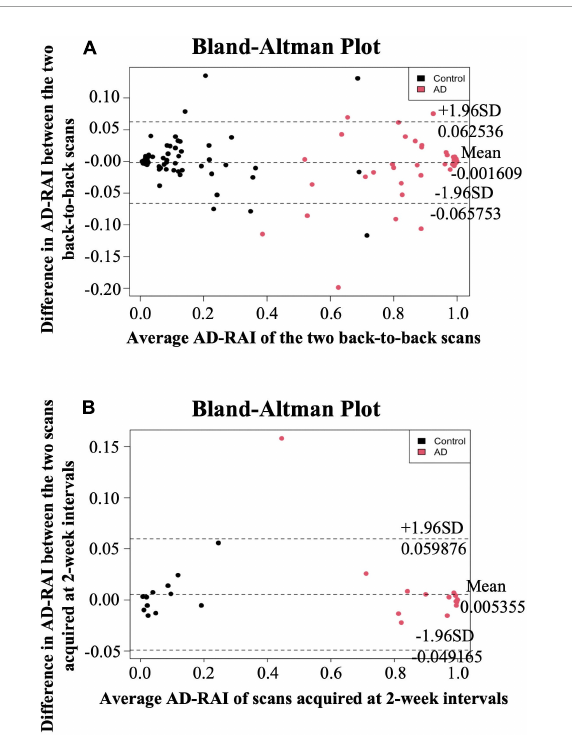
FIGURE1 Bland-Altman plots for same-day repeatability and 2-week reproducibility analysis. The difference in AD-RAI of the paired scans [two back-to-back scans (A) or the two scans acquired at 2-week intervals (B) ] was plotted against their average. The dashed lines in the middle, top and bottom indicate the mean difference, the mean difference plus or minus 1.96 times the standard deviation (SD) of the difference, respectively. AD-RAI, Alzheimer’s disease-resemblance atrophy